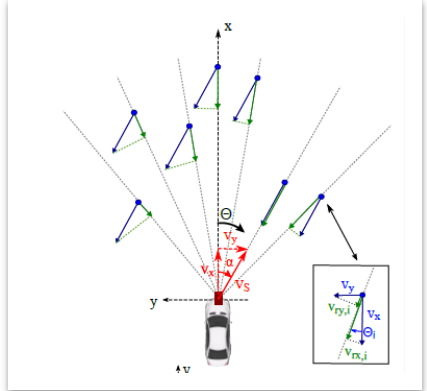
Figure 2. Stationary targets (blue) the radial velocity(green arrow) of the relative velocity (blue arrow) is measured by the Doppler Radar.